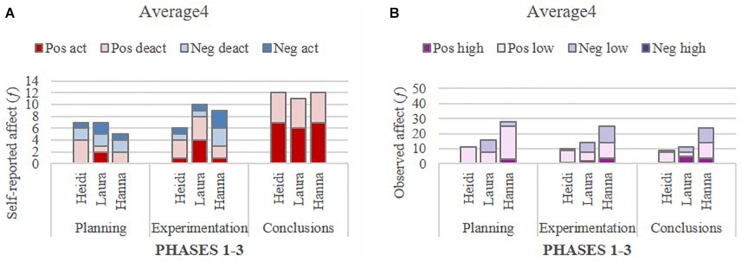
Self-reported (A) and observed (B) affect in the group Average4.